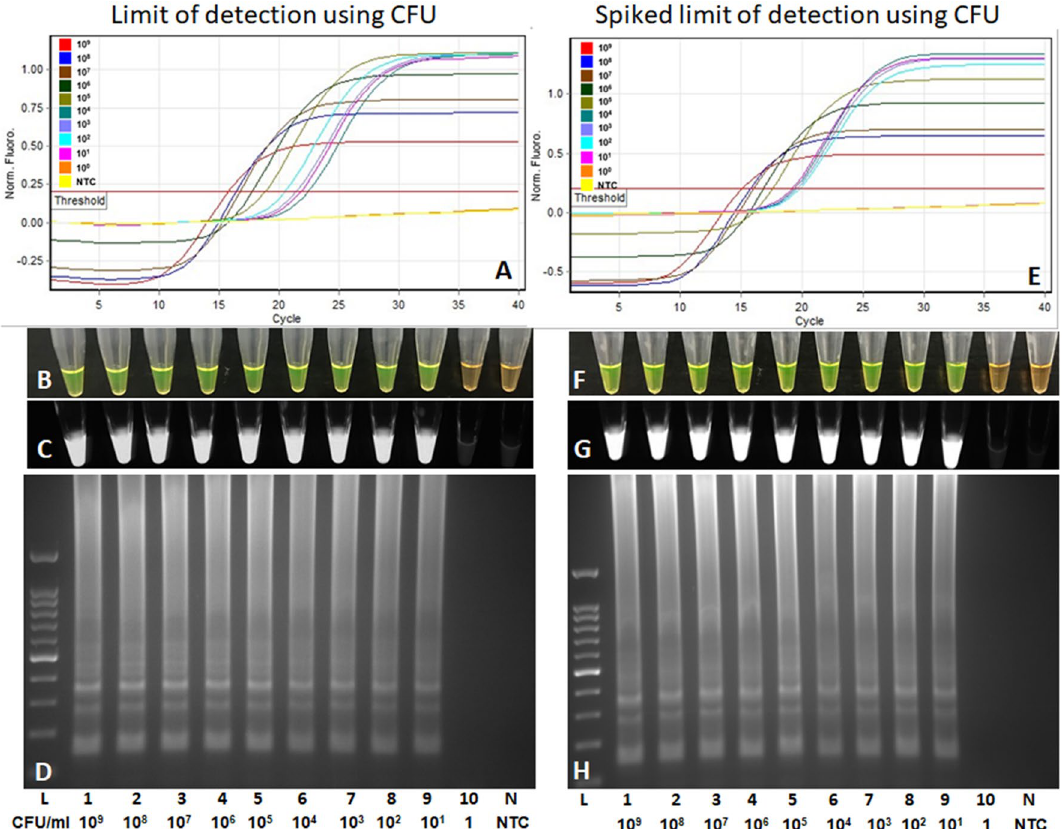
Figure 5. Detection limit of Pectobacterium parmentieri specific loop-mediated isothermal amplification (LAMP) assay using heat-killed bacterial cells. Ten-fold serially diluted bacterial cells (LMG 29,774) starting from 10 9 CFU/mL to 1 CFU/mL per reaction, indicated with lane 1 to 10. ( A , E ) Sigmoidal curves; ( B , F ) by adding SYBR Green I dye, color change from orange to bright green observed with naked eyes; ( C , G ) tubes observed under the UV light; ( D , H ) electrophoresis of amplified products on 2% agarose gel stained with ethidium bromide. Positive amplification was observed up to 10 CFU (lane 9). Lane N is negative control (non- template control—water) and L is a 100 bp ladder. In the spiked assay, a 5 µl of crude host DNA was added to each reaction containing tenfold serially diluted heat killed bacterial